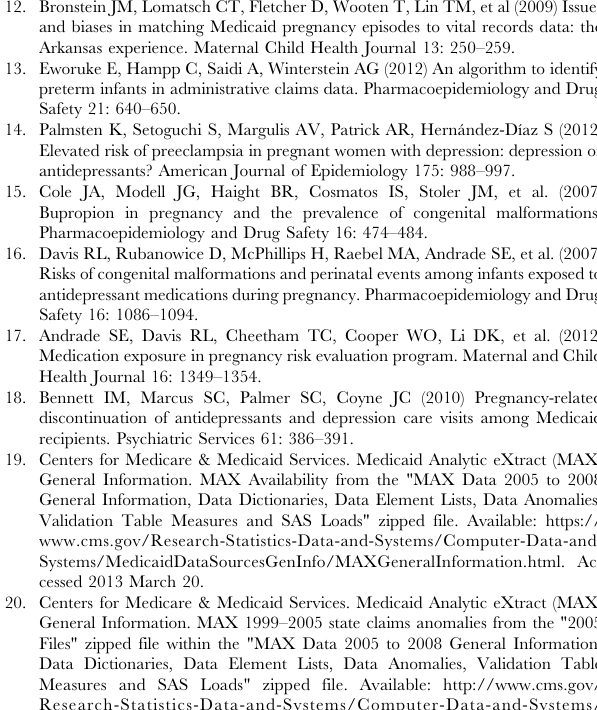
Figure S1 Cohort outcomes; Medicaid Analytic eXtract,